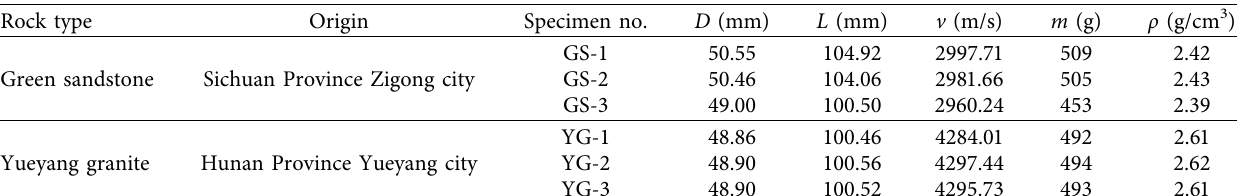
Table 1: Basis parameters of the tested rock specimens.